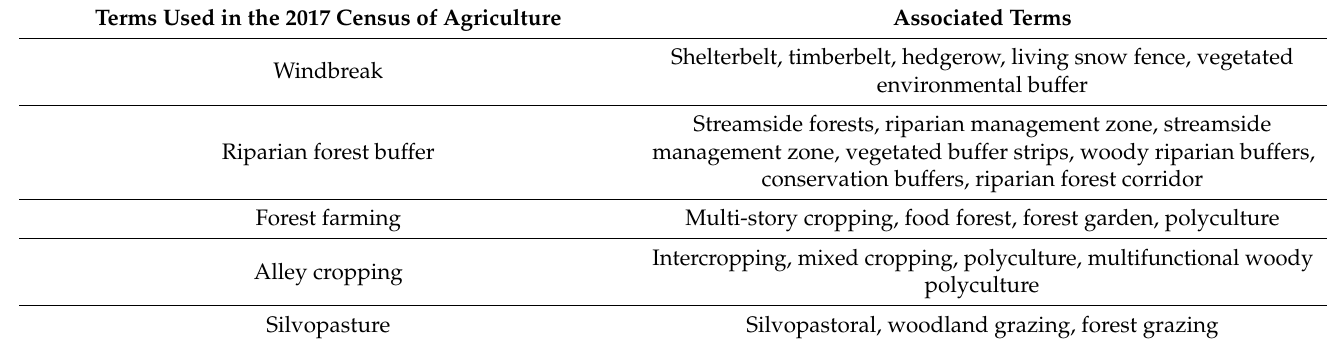
Table 2. Agroforestry practices identified in the 2017 Census of Agriculture and other terms associated with those practices in the